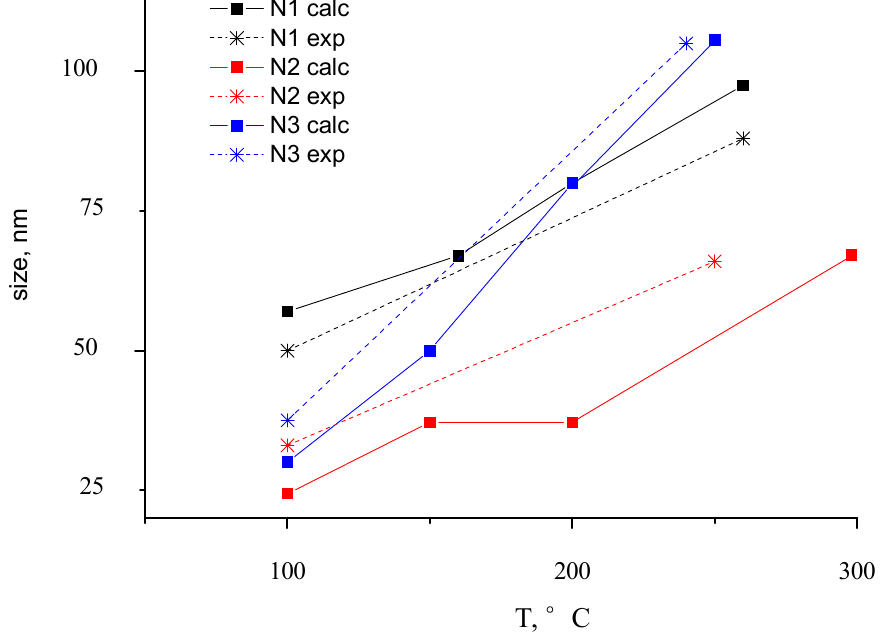
Figure 8. The dependence between particle size and annealing temperature. Experimental and theoretical dependence is shown for Au-PTFE film with different Au concentration (Samples